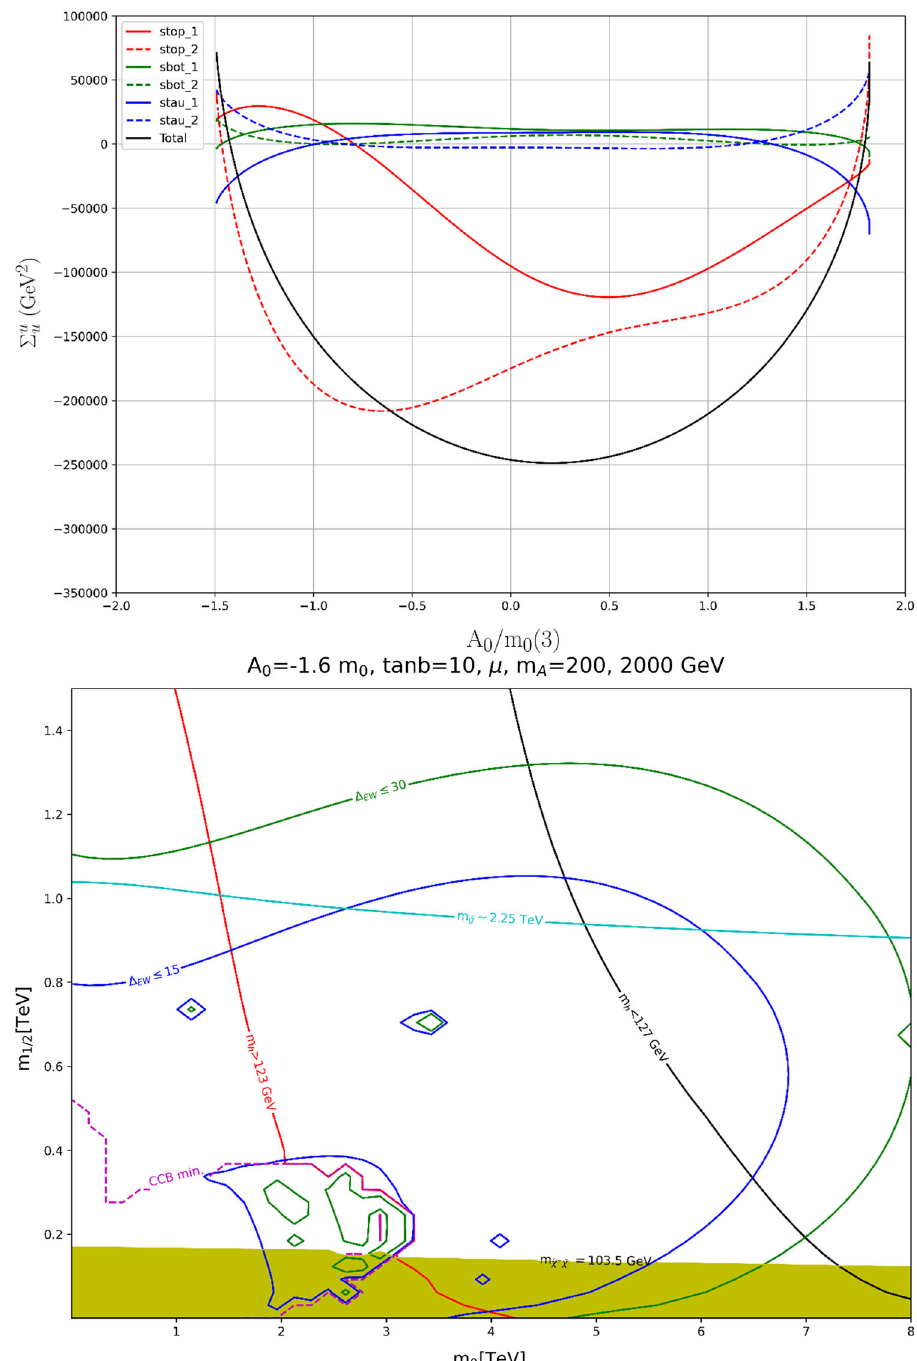
Fig. 3 Third generation contributions to (cid:2) EW for the same model parameters as Fig. 2 vs. A 0 / m 0 ( 3 ) in the m 0 vs. m 1 / 2 plane of the NUHM2 model with μ = 200, tan β = 10,